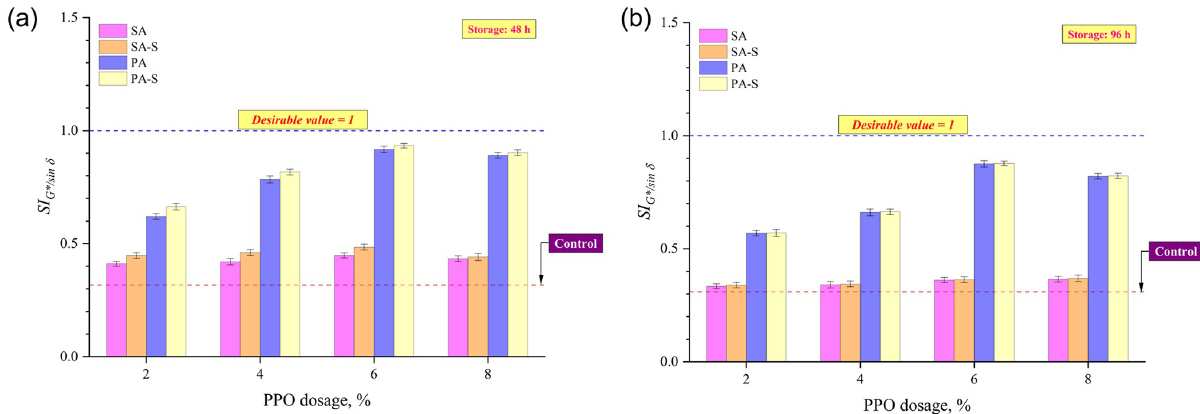
Fig 7. SI based on G * /sin δ after (a) 48 h and (b) 96 h of thermal storage.